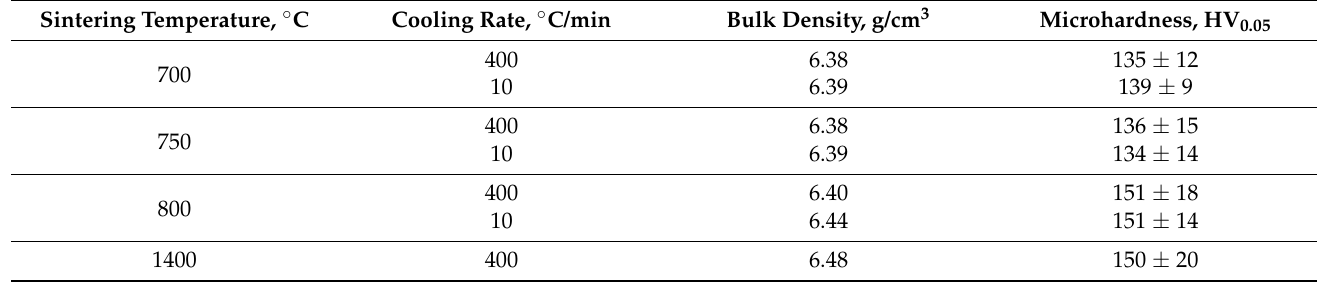
Table 3. Bulk density and microhardness of zirconium spark plasma sintered at various temperatures and cooling rates. Sintering Temperature, ◦ C